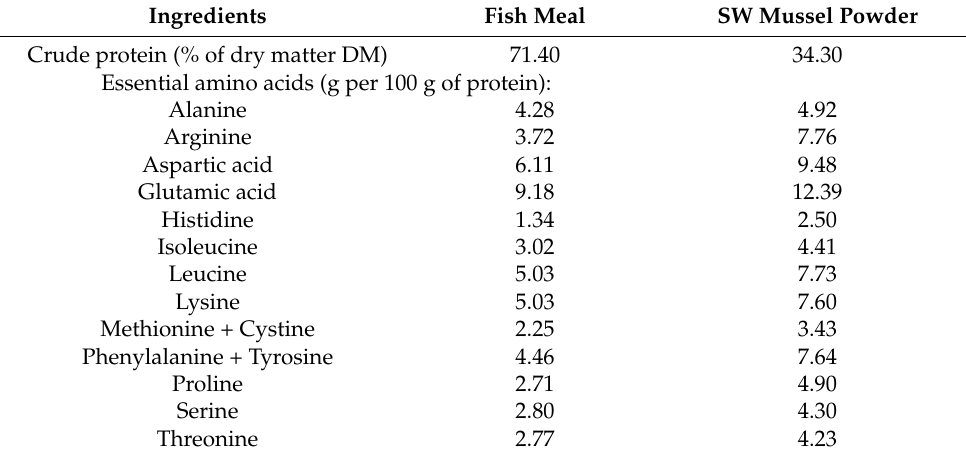
Table 3. Protein and amino acid composition of fish meal and S. woodiana mussel powder.